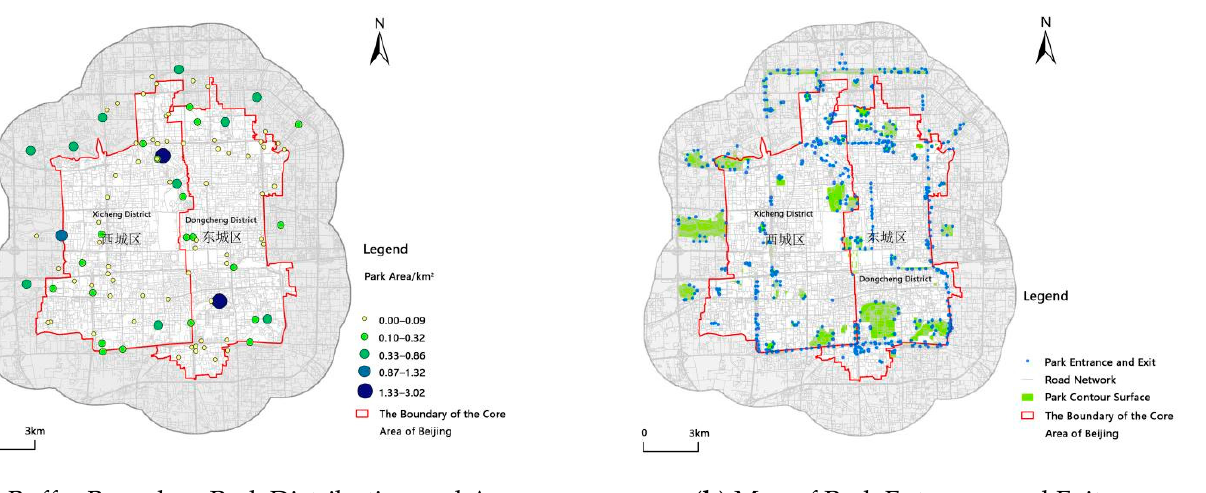
Figure 2. Park entrances and distribution in the core area of Beijing: ( a ) Defines the distribution and size of parks in the research area; ( b ) defines the entrances and exits parks in the research